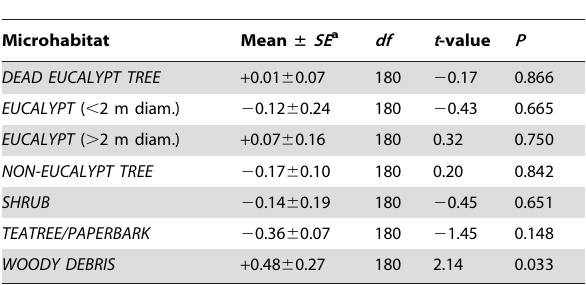
Table 3. Relationships between blood cell indicators of stress and health status and Mass-Size Residuals (g) for male agile antechinus.